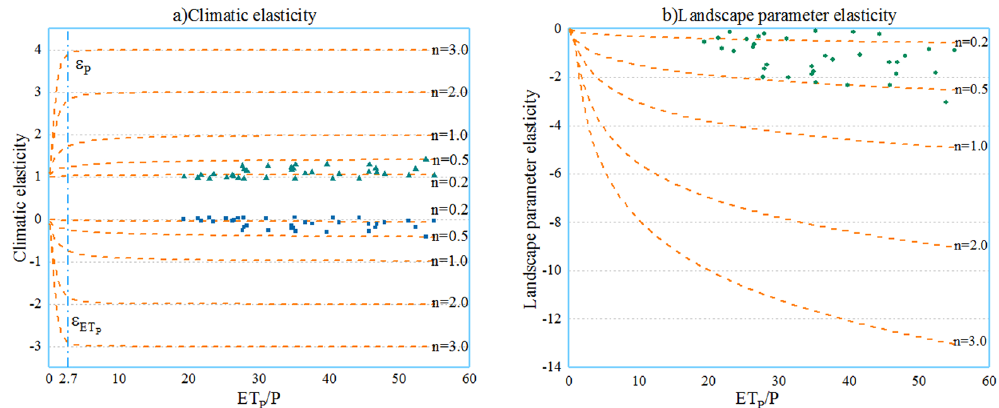
Figure 6. Relationship between the climate elasticity/landscape elasticity of streamflow and the aridity index (Note: the lines represents the elasticity of streamflow, the green triangles represent ε ε and the green squares represent ε ET P